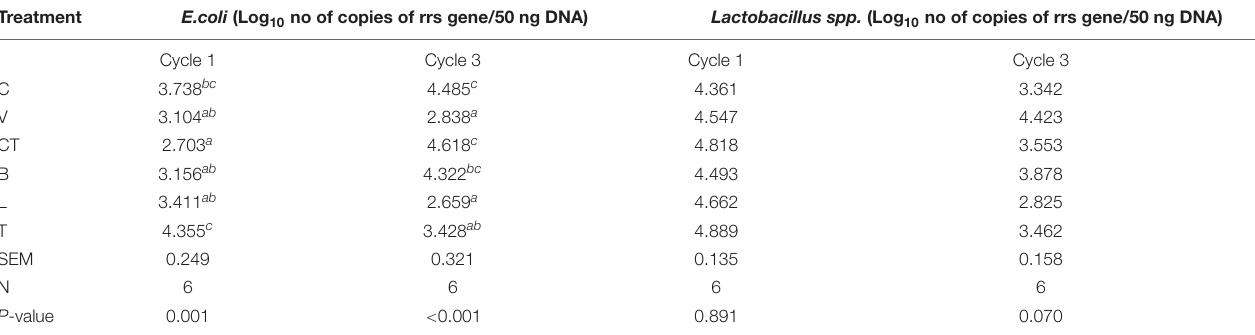
TABLE 2 | Effects of treatments on the abundance of Escherichia coli and Lactobacillus spp. in gut content.